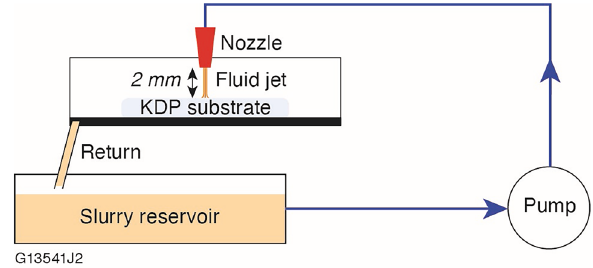
Figure 1. Schematic of the FJP setup used for this